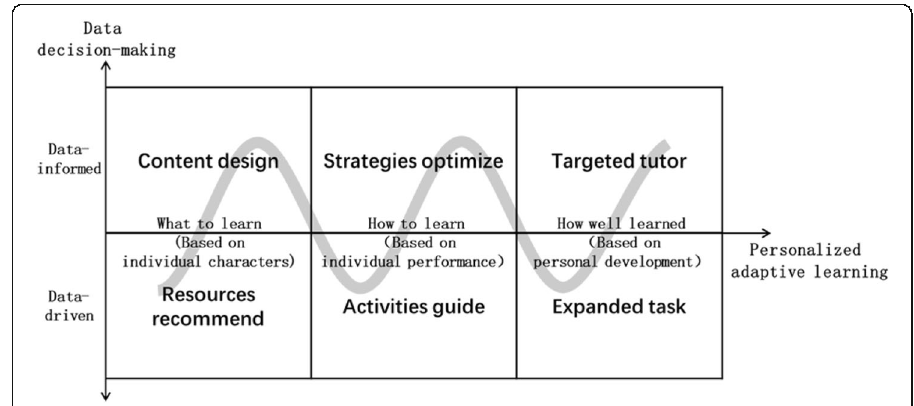
Fig. 3 The spectrum of adaptive adjustment instruction strategies based on man-machine collaborative